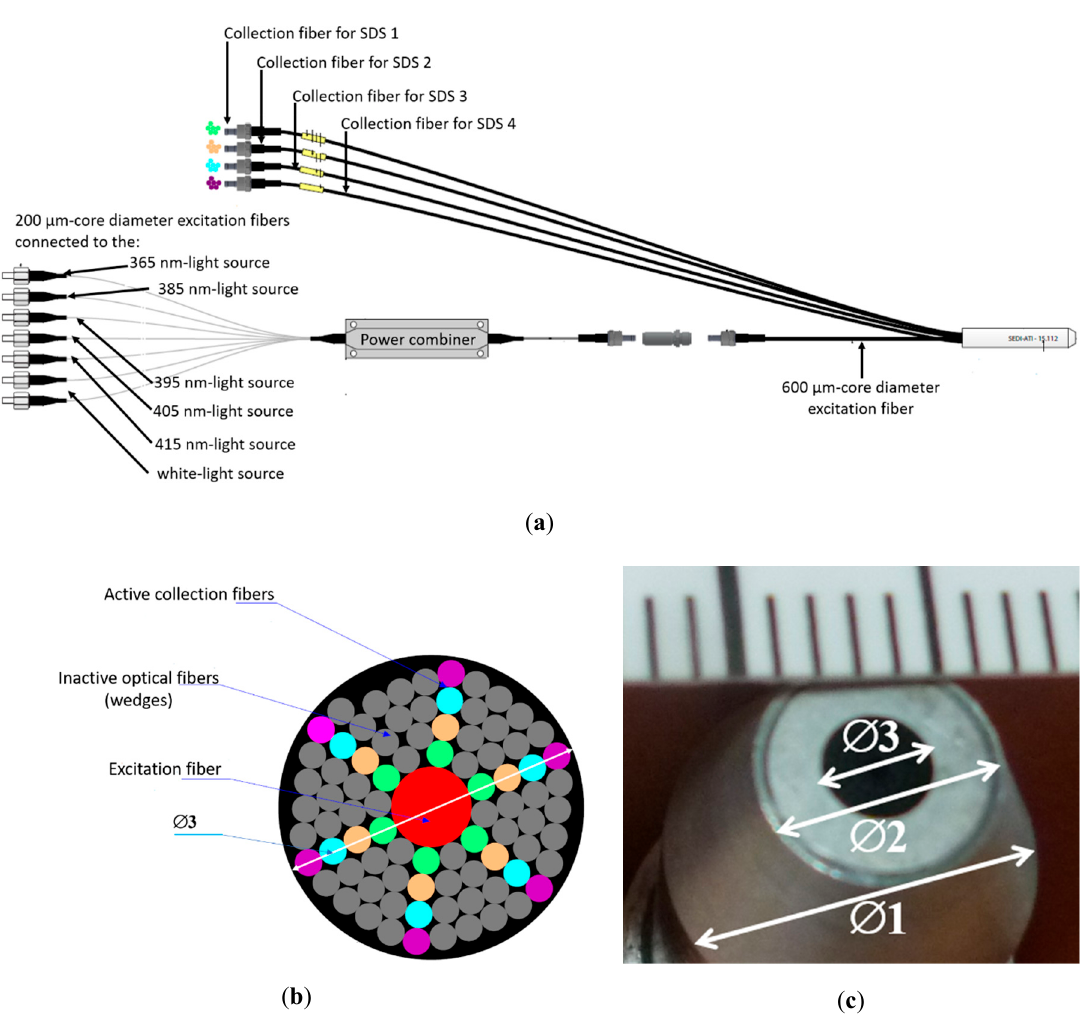
Figure 2. Optical probe used in the SpectroLive device. ( a ) General schematic of the entire probe including excitation fibers each connected to one of the six excitation light sources, merged into a single 600 µ m-core diameter excitation fiber and collection optical fibers, each connected to a spectrometer, each corresponding to a specific source-to-detector separation (SDS). ( b ) Schematic of the optical probe showing the 84 optical fibers around the central excitation fiber (600 µ m-core diameter): 60 grey optical fibers are inactive and used as wedges for the 24 active collection fibers shown in the figure as colored fibers. The green (respectively orange, blue and purple) ones correspond to first SDS1 (respectively SDS2, SDS3 and SDS4). For each colored ring, the six fibers are merged into the collection fibers. The diameter of the whole section is 3.5 mm. ( c ) Picture of the probe end: outer diameter ∅ 1 is 10 mm, tip diameter ∅ 2 is 6.5 mm, and fiber optics area measurement diameter ∅ 3 is 3.5 mm.